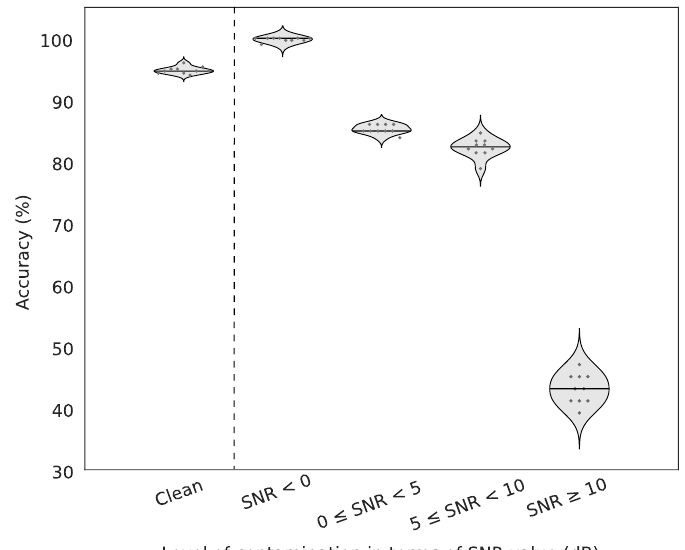
Figure 4. Accuracy of EEG quality checker for different levels of contamination. The accuracy of detection is assessed on no contaminated data (referred as “Clean”) and for different levels of contaminated data. The level of contamination is described by the SNR value as explained in Section 2.6.1. Ten independent runs were performed to compute the accuracies of detection. Each run was done with a 5-fold cross validation. The straight line in each violin plot represents the median